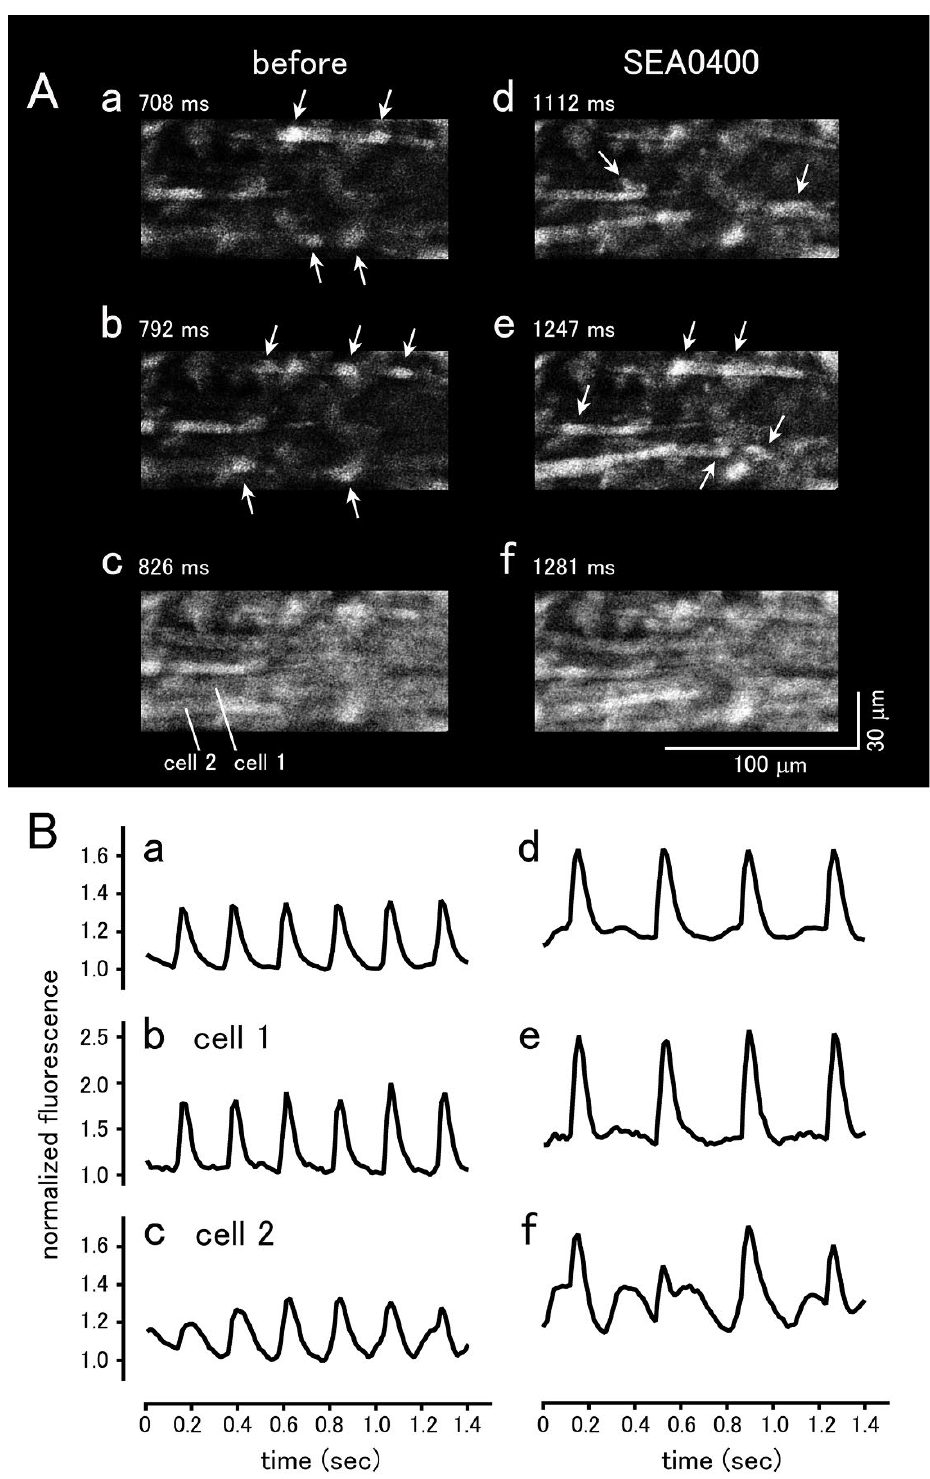
Figure 5. Effect of SEA0400 on spontaneously occurring Ca 2+ transients in the mouse sinus node tissue. ( A ) Typical x-y images of the myocardium loaded with Cal-590 before ( a – c ) and 10 min after the addition of 1 µ M SEA0400 ( d – f ). Panels c and f are the images at the peak of the Ca 2+ transient. Note that Ca 2+ oscillations were observed during the interval between the Ca 2+ transients (arrows). ( B ) Time course of the changes in fluorescence before addition ( a – c ) and 10 min after the addition of 1 µ M SEA0400 ( d – f ). Time course of the fluorescence intensity quantified in the whole field of view ( a , d ), cell 1 ( b , e ), and cell 2 ( c , f ) as shown in panel ( A )/( c ).